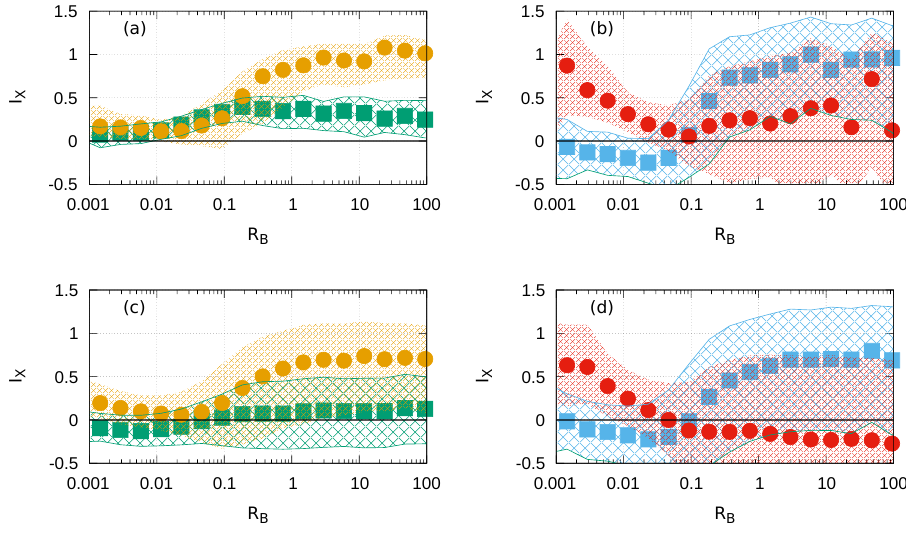
Figure 1. Median values (symbols) and the range of 25–75% percentiles (filled areas) as a function of R B for: I (cid:104) u 2 (cid:105) + (cid:104) v 2 (cid:105) (green squares) and I (cid:104) w 2 (cid:105) (brown dots) ( a , c ); I τ (blue squares) and I (cid:104) w θ (cid:105) (red dots) ( b , d ). ( a , b ) are for 30 min averaging time; ( c , d ) are for 2 min averaging